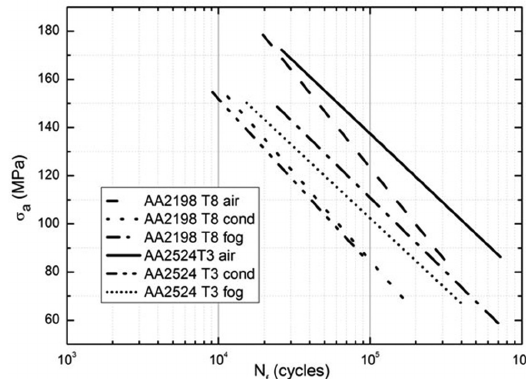
Figure 1. Size and geometry of the (a) tensile and (b) fatigue specimens. The dimensions are in mm.